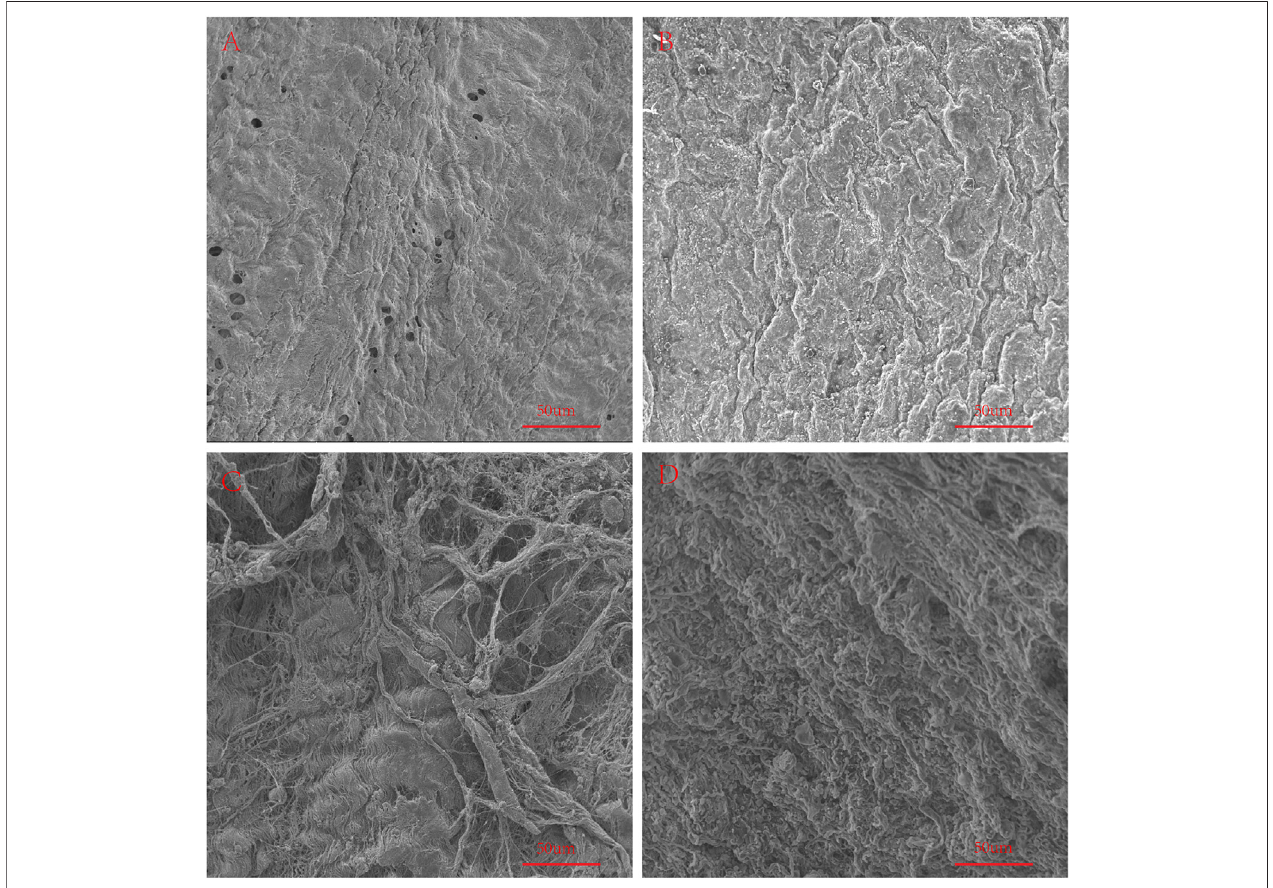
FIGURE 6 | SEM to observe the surface structure of fresh samples. (A) , Fresh yak pericardium (YP); (B) , Fresh Australian bovine pericardium (AP); (C) , Fresh local bovine pericardium (LP); (D) , Fresh porcine pericardium (PP). scale bars are 50 um.